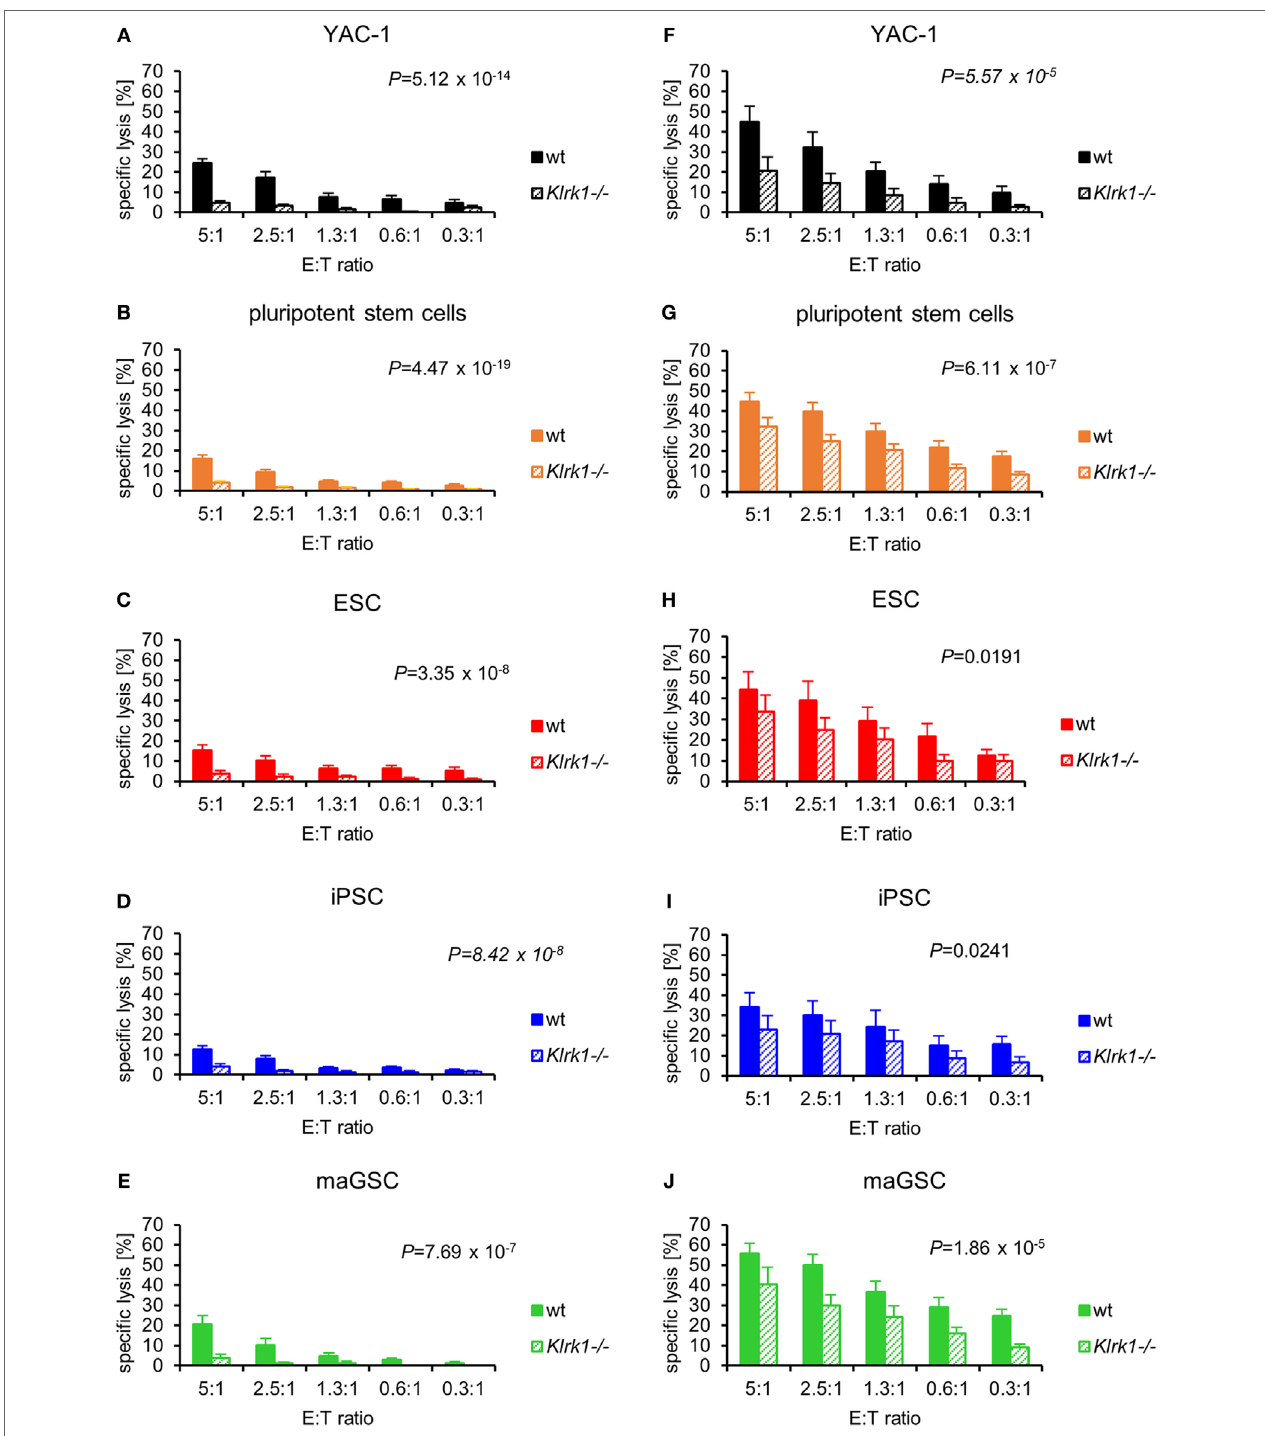
FigUre 4 | Pluripotent stem cells (PSCs) are largely resistant against resting NKG2D-deficient natural killer (NK) cells, whereas the cytotoxic activity of interleukin- 2-activated NK cells depends only partly on NKG2D. The cytotoxic activity of resting wild-type (wt) and NKG2D-deficient ( Klrk1 − / − ) NK cells has been compared for (a) YAC-1 cells (wt: n = 8, Klrk1 − / − : n = 8), (B) all PSCs together (wt: n = 24, Klrk1 − / − : n = 24), (c) embryonic stem cells (ESCs) (wt: n = 7, Klrk1 − / − : n = 7), (D) induced pluripotent stem cells (iPSCs) (wt: n = 9, Klrk1 − / − : n = 9), and (e) multipotent adult germline stem cell (maGSCs) (wt: n = 8, Klrk1 − / − : n = 8). The cytotoxic activity of IL-2-activated wt and Klrk1 − / − NK cells has been compared for (F) YAC-1 cells (wt: n = 6, Klrk1 − / − : n = 6), (g) all PSCs together (wt: n = 18, Klrk1 − / − : n = 18), (h) ESCs (wt: n = 6, Klrk1 − / − : n = 6), (i) iPSCs (wt: n = 6, Klrk1 − / − : n = 6), and (J) maGSCs (wt: n = 6, Klrk1 − / − : n = 6). P -values for the comparisons (2-way-analyses of variance adjusted for E:T ratios) are indicated.